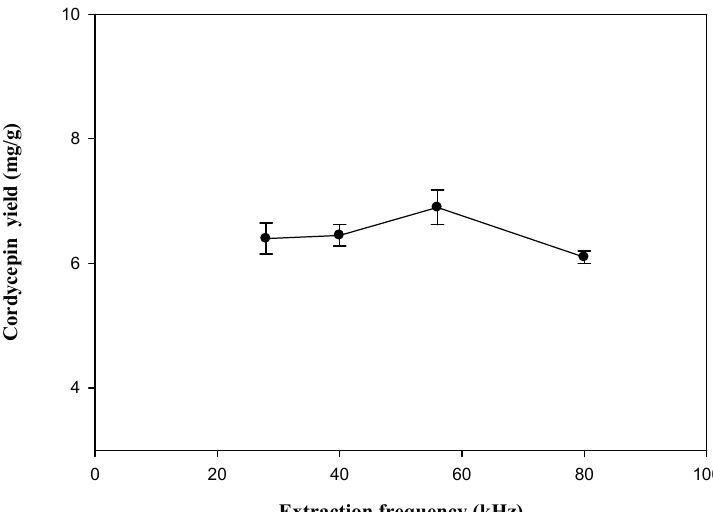
Figure 6. Effect of extraction frequency on the extraction yield of cordycepin from C. militaris . Extraction time: 50 min; ethanol concentration: 50%; extraction temperature: 60 °C; ratio of liquid to solid: 20